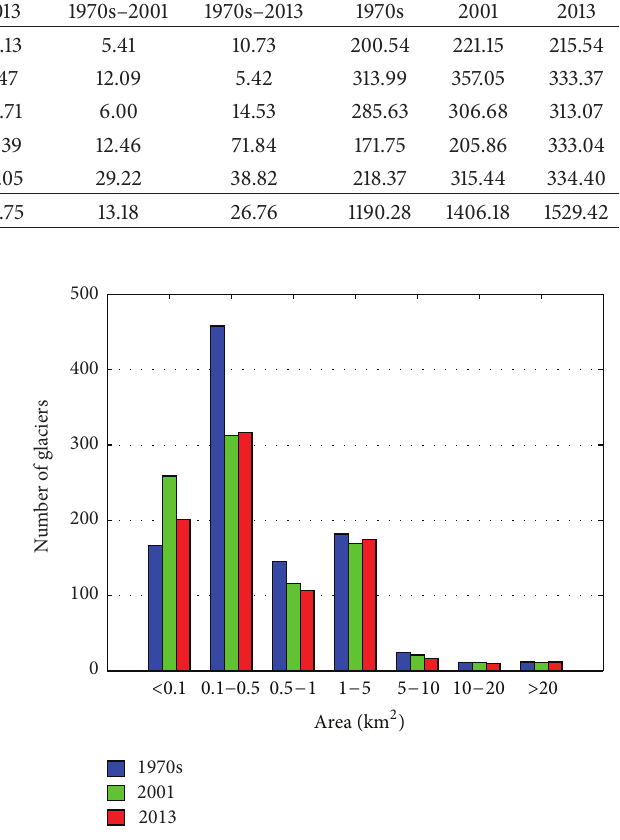
Table 2: Summary of glacial lake inventories in the Pumqu river basin for the 1970s, 2001, and 2013 periods. Number of glacial lakes Areas of glacial lakes (km 2 ) Increasing ratio of area (%) Lake volume (10 6 m 3 ) Subbasin